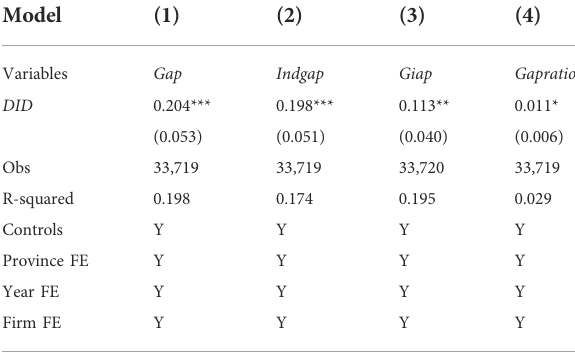
TABLE 3 Baseline regression with different dependent variables.